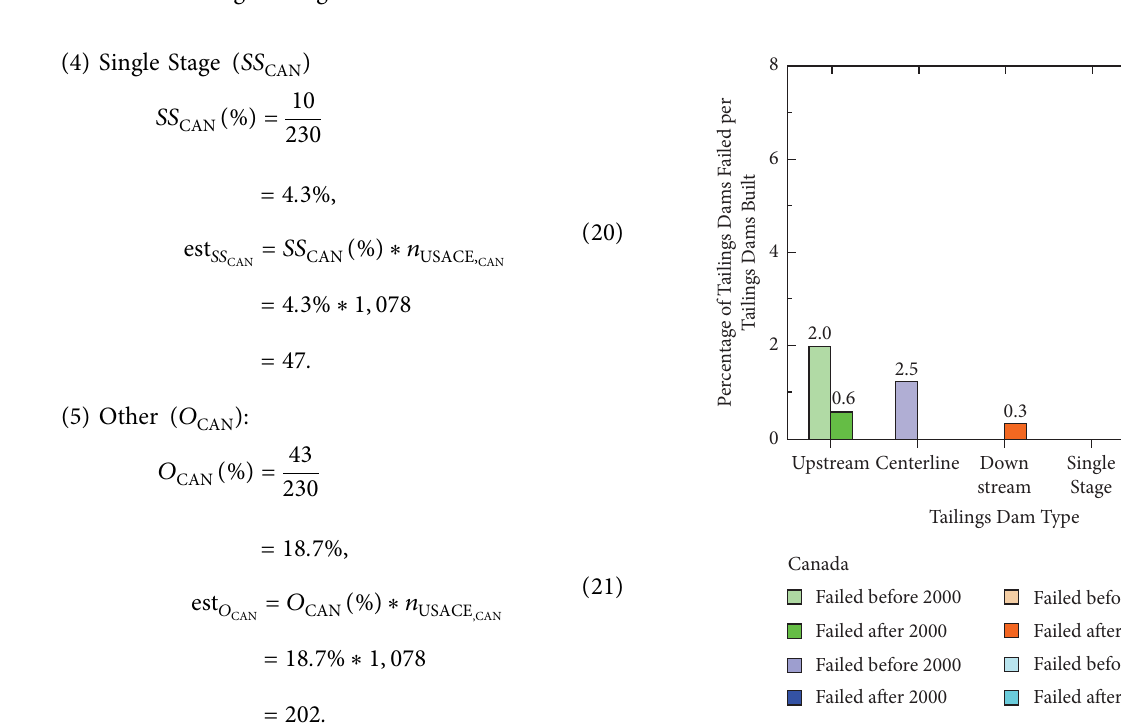
Figure 7: Percentage of tailings dams failed per tailings dams built in Canada, before and after 2000, according to dam type (data from GRID-Arendal [25] and Bowker